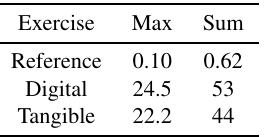
Table 2: The minimum distances from reference stream cells to the nearest modeled cell with concentrated flow (ft)